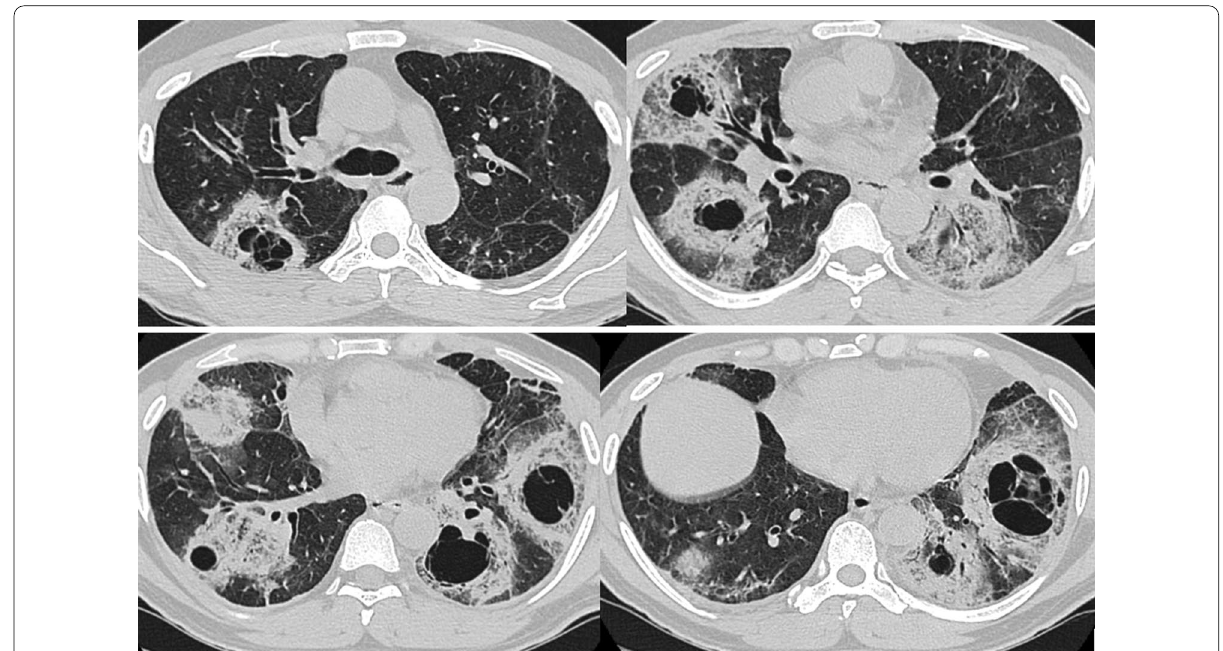
Fig. 3 Axial HRCT scans showing imaging features of Mucormycosis in Case 3 of COVID-19. CT axial images shows multiple cavitary lesions with irregular nodular growth and internal septations, in both lungs, look like arising from pre-existing reverse halo